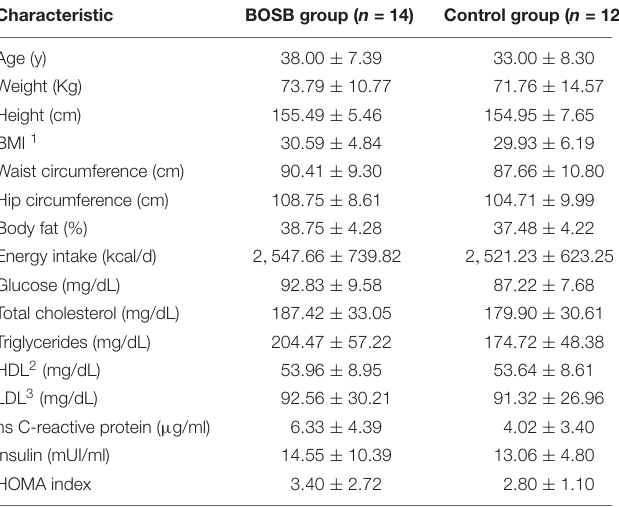
TABLE 2 | Baseline characteristics of